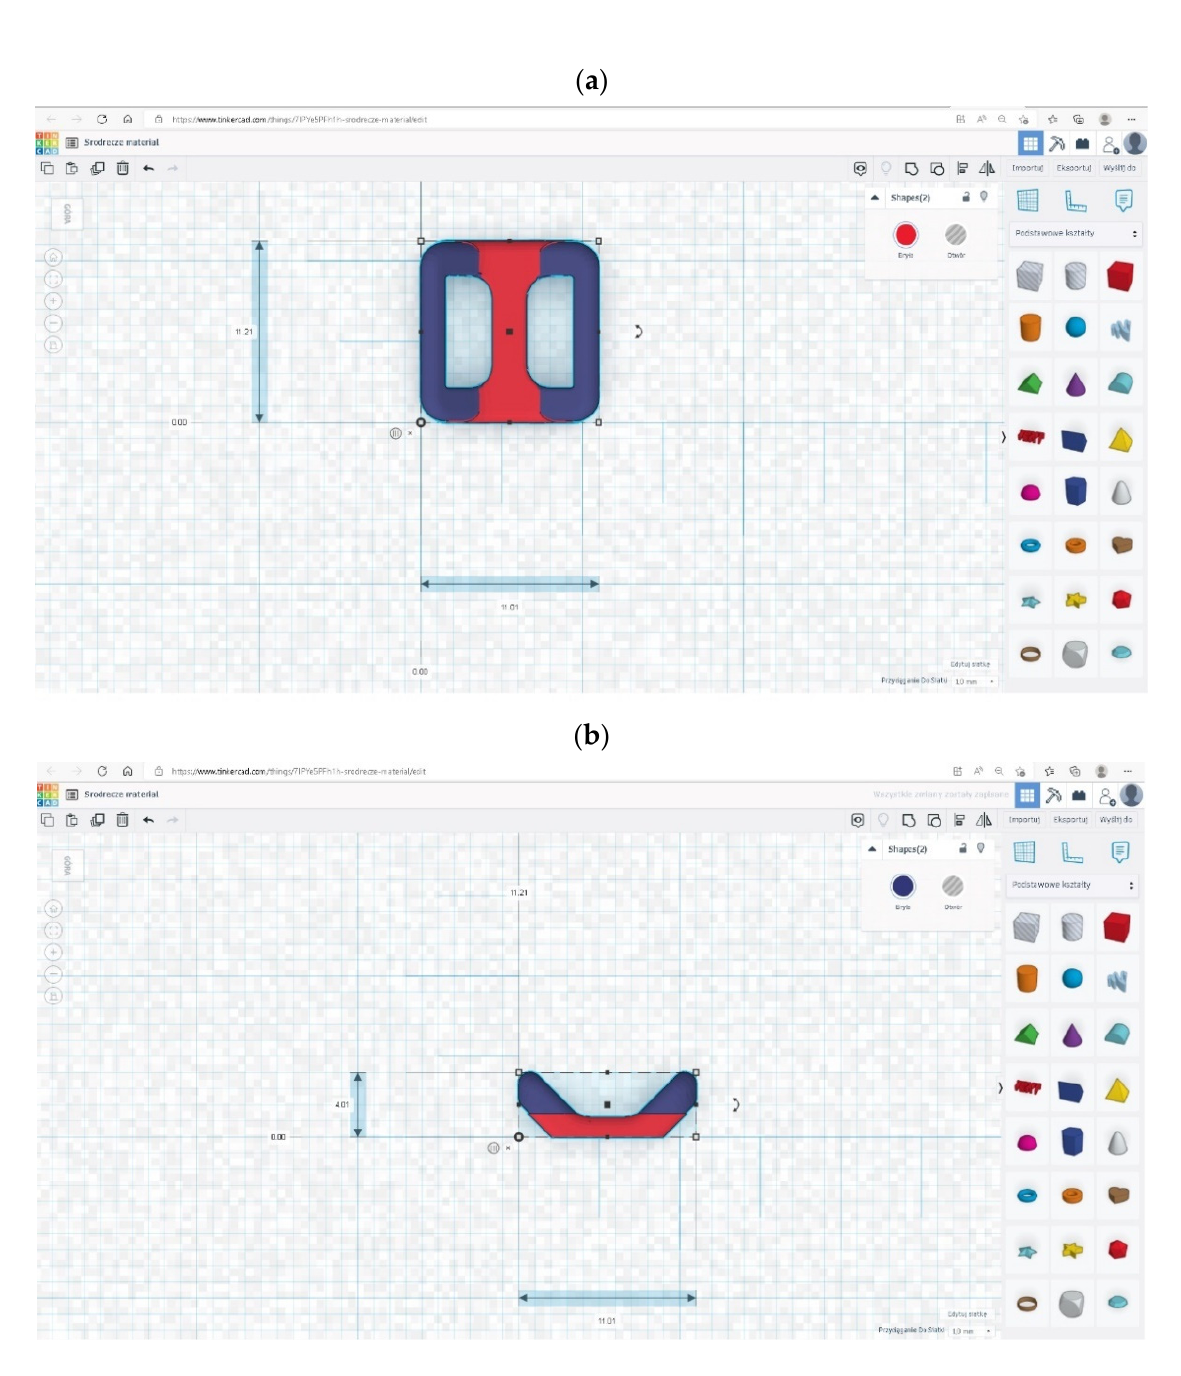
Figure 4. Construction of a single element: ( a ) top view, ( b ) side view. Individual pieces were assembled into chainmail (Figures 5 and 6).